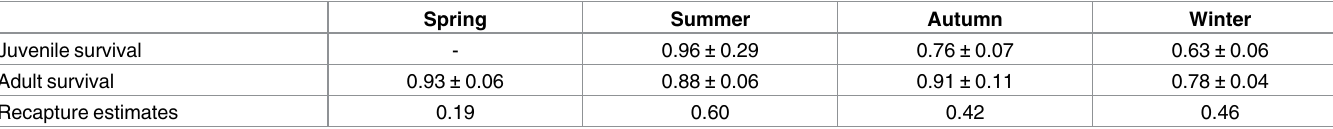
Table 2. Parameterestimatesfrom best-fit model for juveniles and adults survival, with standard